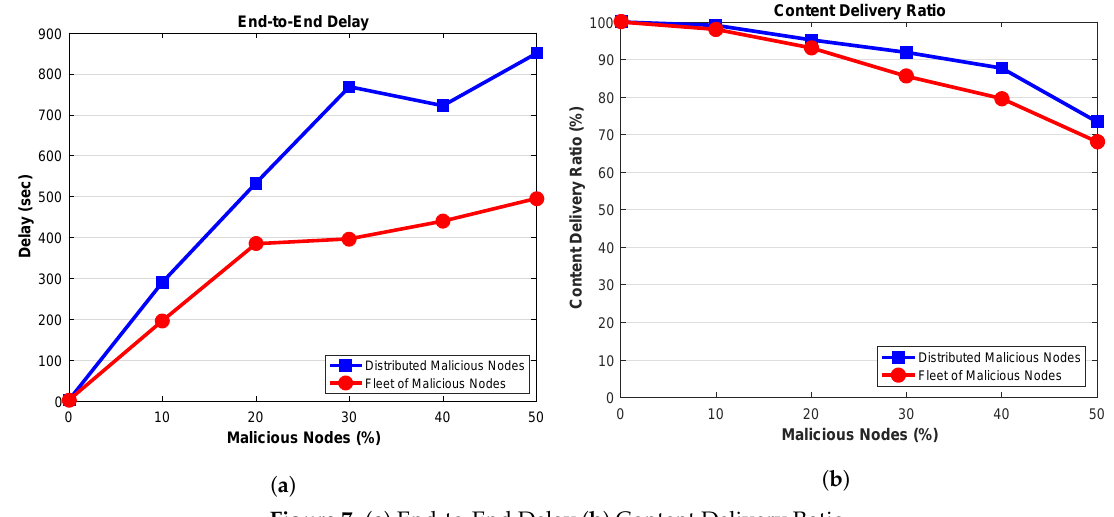
Figure 7. ( a ) End-to-End Delay ( b ) Content Delivery